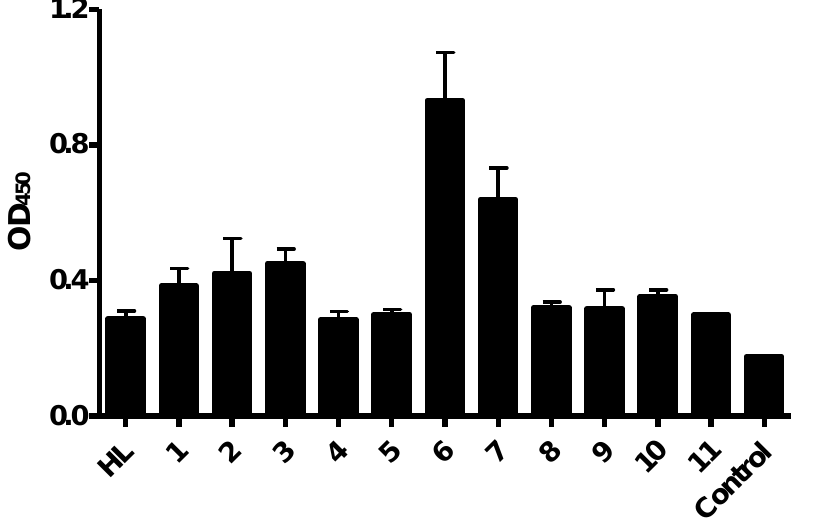
Figure 3. Binding characteristics of phage-displayed anti-CD22 scFvs. Different scFv mutants were displayed with phagemid vector. Overnight cultures of scFv-phages were incubated with Raji cell membrane, and bound scFv-phages were detected with an HRP-conjugated anti-M13 secondary antibody. HL represents the parental scFv clone. M13KO7 helper phages are used as the negative control. Data shown are means ± SEM of 2 – 3 separate experiments each performed in triplicate.